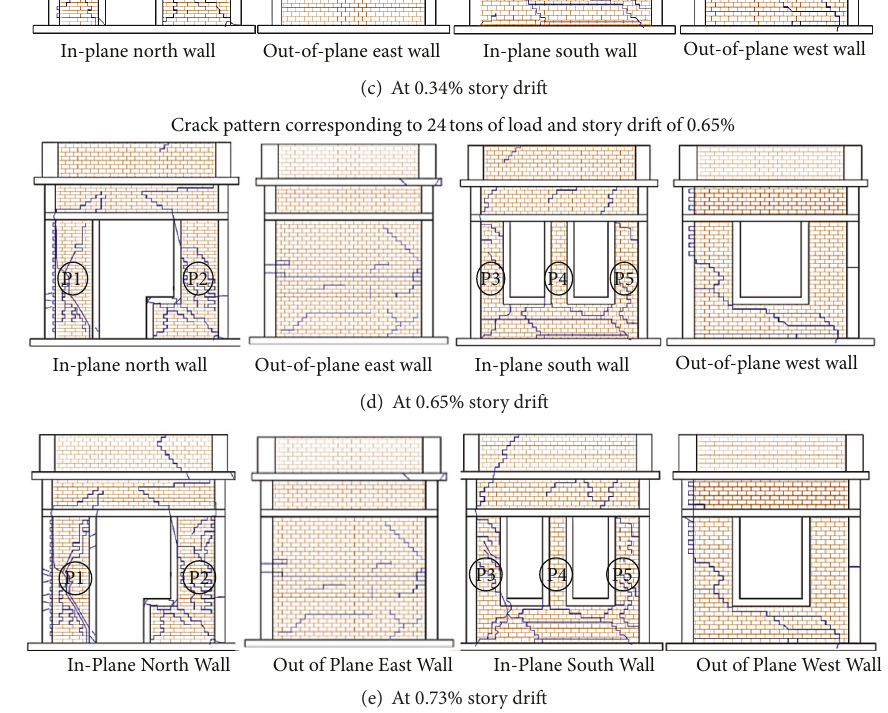
Figure 6: Crack patterns at different drift levels for the intact building (note: P stands for